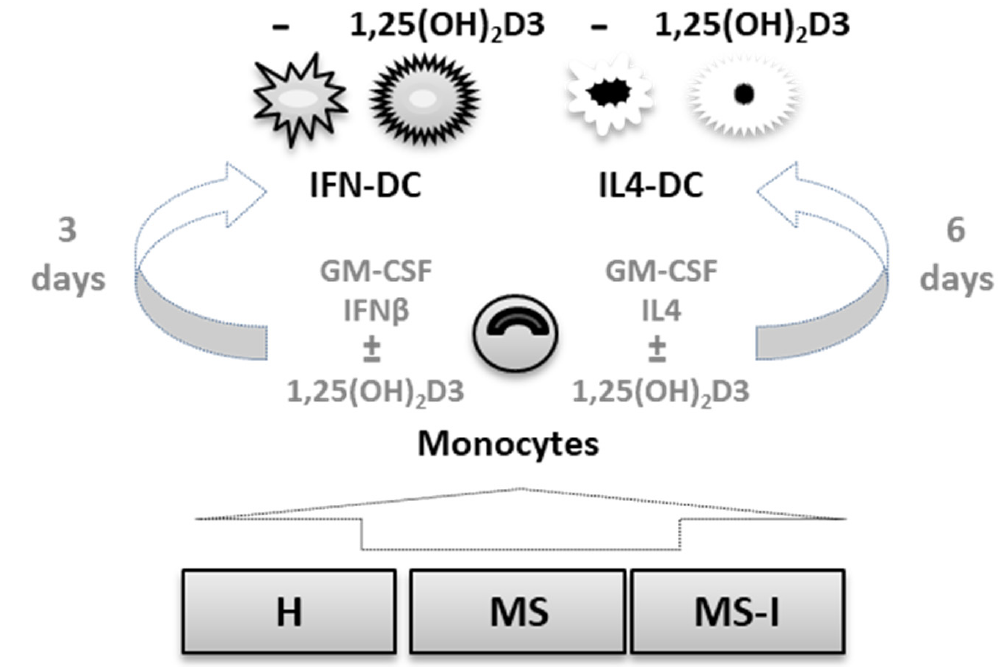
Figure 1. Cell models. CD14 + monocytes were obtained from three groups of donors: healthy donors, H; relapsing remitting multiple sclerosis (RRMS) patients free of therapy, MS; RRMS patients undergoing interferon (IFN) therapy, MS-I. Monocytes were in vitro differentiated into IFN-DC or IL4-DC, in the presence or in the absence of 10 nM 1,25-dihydroxyvitamin D3 (1,25(OH) 2 D3). As shown in Figure 2, both IFN-DC (Figure 2a) and IL4-DC (Figure 2b) from the three donor groups constitutively express VDR mRNA. The presence of 1,25(OH) 2 D3 did not significantly change VDR mRNA expression levels in IFN-DC in any donor group, accordingly to what was previously observed in IFN-DC obtained from buffy coats of healthy donors [24]. A trend toward a reduction—although not statistically significant— was observed in IL4-DC from the three groups of donors in response to 1,25(OH) 2 D3. No significant differences were observed among the three donor groups, although a trend toward higher basal expression in IFN-DC obtained from MS-I patients is observable. Interestingly, after pooling data obtained from the three donor groups, we did observe a significantly higher VDR expression in IFN-DC compared to IL4-DC (Figure 2c). The basal expression of CYP24A1 mRNA was generally under the detection limit but it was readily induced in the presence of 1,25(OH) 2 D3 (Figure 2d,e) at comparable levels in the three donor groups and in the two cell models (Figure